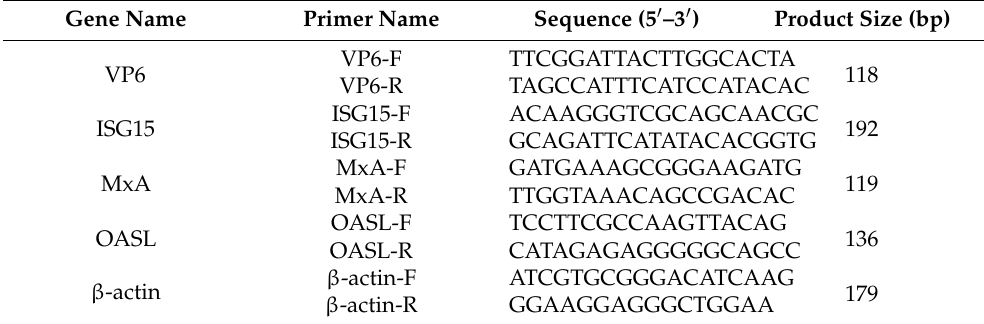
Table 1. Primers used in this